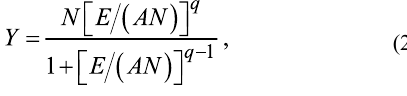
where k and n are parameters describing the collision of the clusters with the residual gas, E is the cluster energy, and E th is the sputtering threshold energy. The threshold energy has